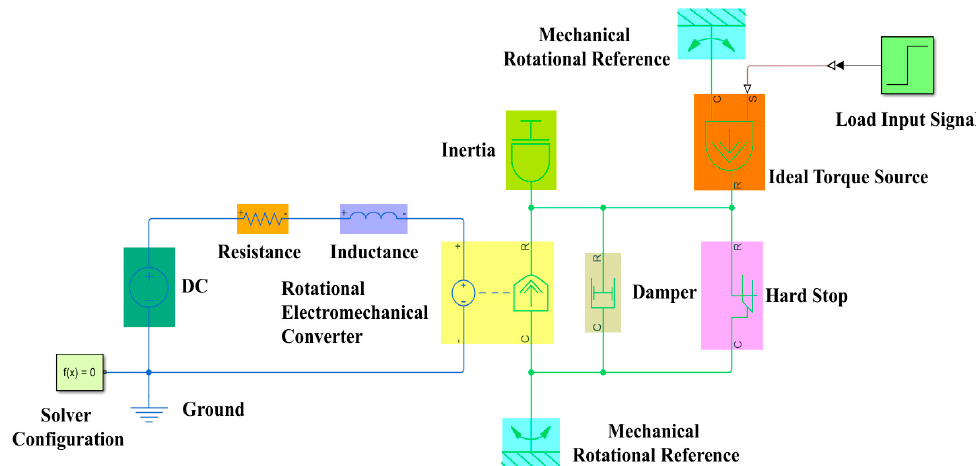
Figure 2. Physical model of limited-angle torque motor.